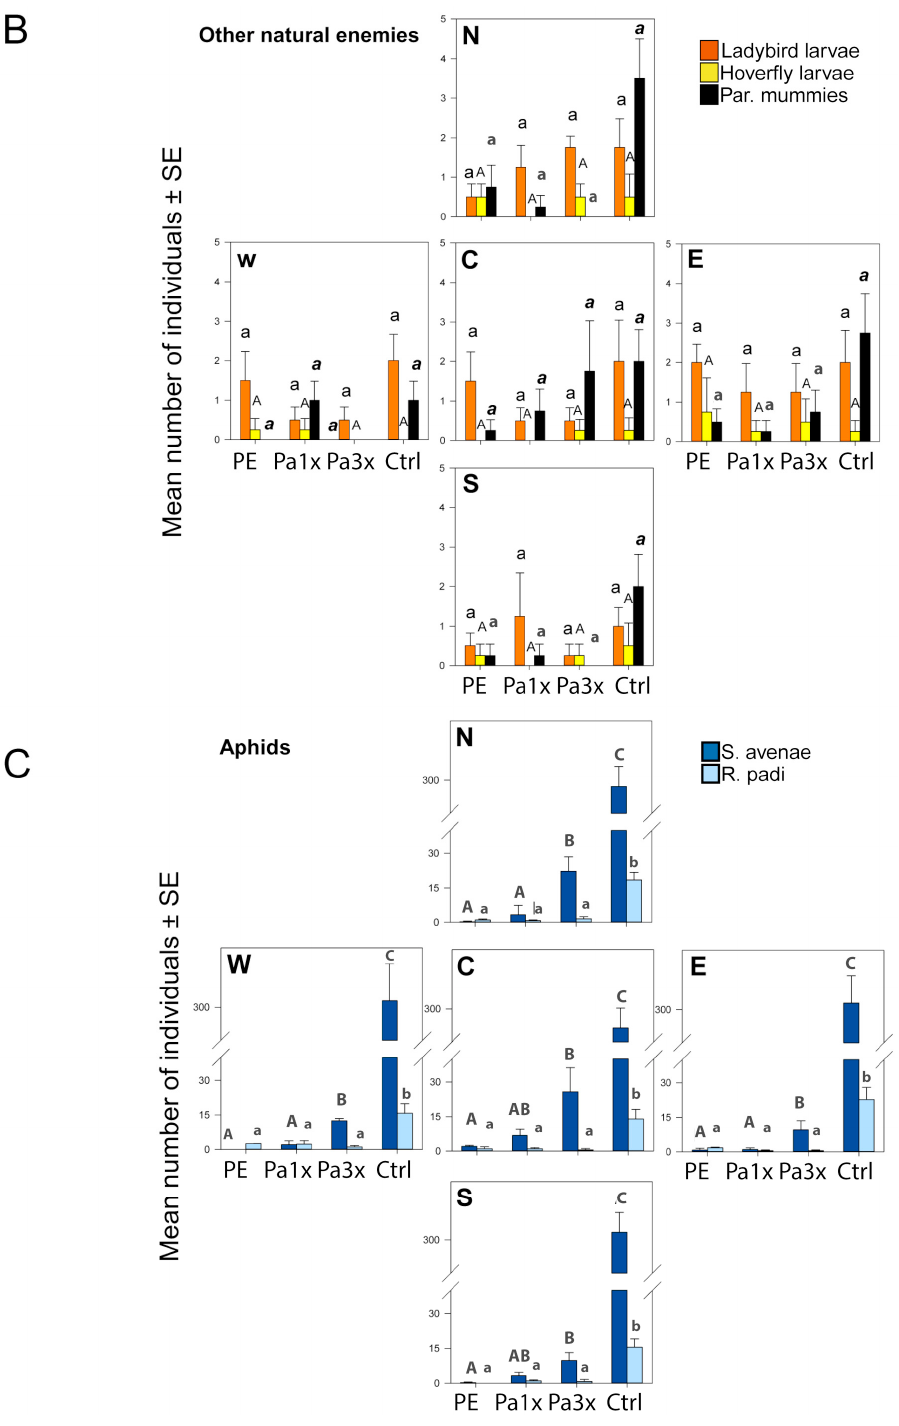
Figure 4. Cumulated number of individuals ( ± SE) of natural enemies and aphids measured on three barley plants in the central (C) sector of the plot and on plants located at 30 cm north (N), south (S), east (E), and west (W) from the central sector. Different letters above bars indicate significant differences between formulations in each sector for ( A ) lacewing eggs (lowercase) and larvae (uppercase) (GLMM, Tukey’s test, p < 0.050), ( B ) ladybird (lowercase), hoverfly larvae (uppercase), parasitoid mummies (bold lowercase) (GLMM, Tukey’s test, p < 0.050), ( C ) S. avenae (uppercase) and R. padi (lowercase) (GLMM, Tukey’s test, p < 0.050).